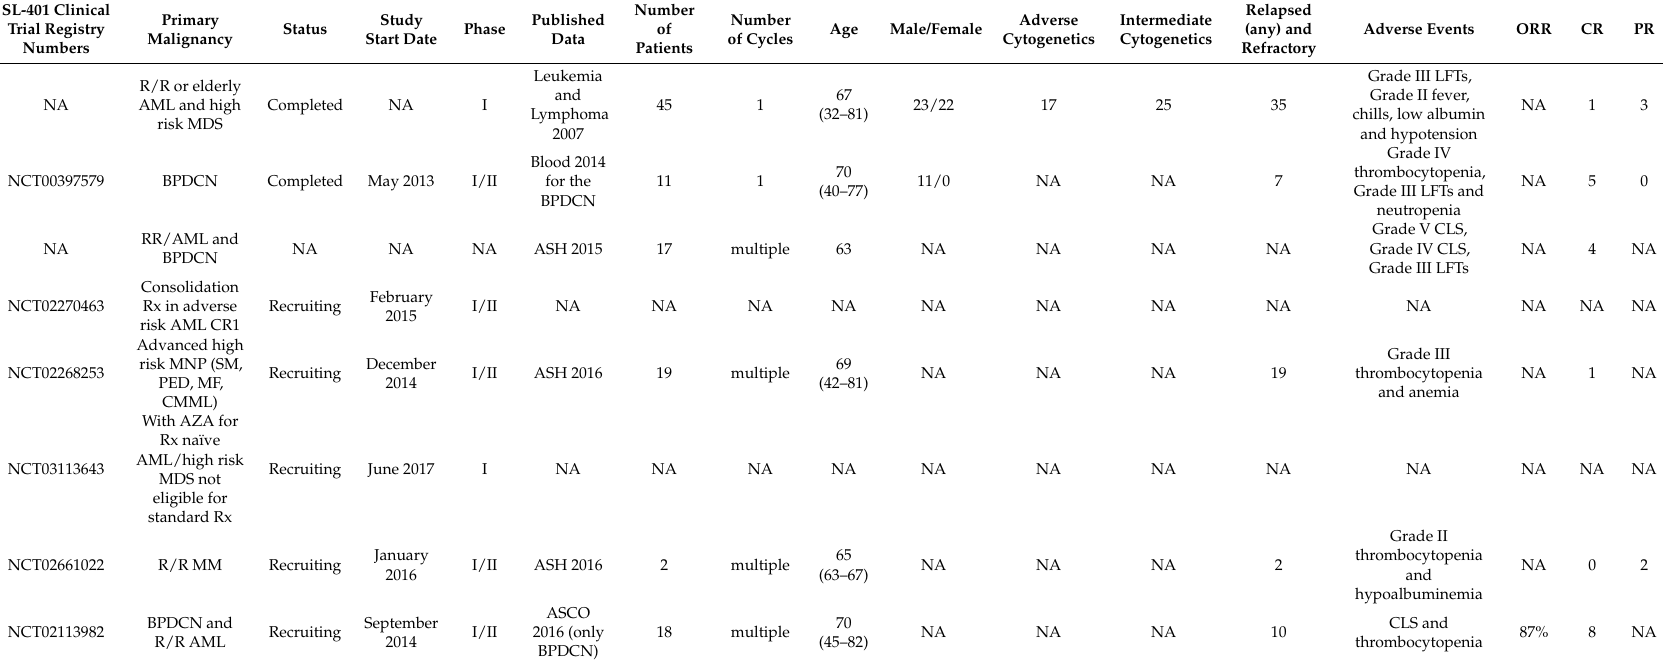
Table 1. Summary of SL-401 clinical trials in various hematologic neoplasms, baseline characteristics, adverse events and clinical outcomes (See page 14). Abbreviations: NCT, National Clinical Trial; R/R, Relapsed or refractory; AML, Acute myeloid leukemia; MDS, Myelodysplastic syndrome; CMML, Chronic myelomonocytic leukemia; BPDCN, Blastic plasmacytoid dendritic cell neoplasm; MM, Multiple myeloma; ORR, Overall response rate; CR, Complete response; PR, Partial response; LFT, Liver function tests; ASCO, American Society of Clinical Oncology; ASH, American Society of Hematology; CLS, Capillary leak syndrome; NA, Not